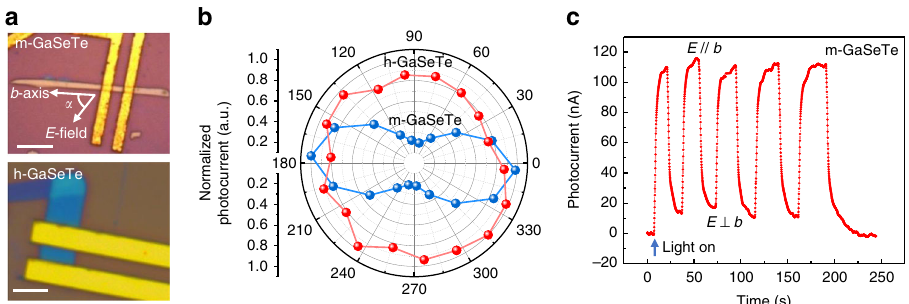
Fig. 3 Phase dependent optoelectronic properties. a Optical images of the GaSeTe devices based on the monoclinic (top, scale bar = 10 μ m) phase and hexagonal (bottom, scale bar = 5 μ m) phase. b Angle resolved photocurrent as a function of light polarization ( E fi eld) direction measured on both devices. c Time resolved photoresponse of the device based on monoclinic GaSeTe ( V ds = − 0.2 V). The light polarization is alternatively switched between parallel and perpendicular to the b -axis